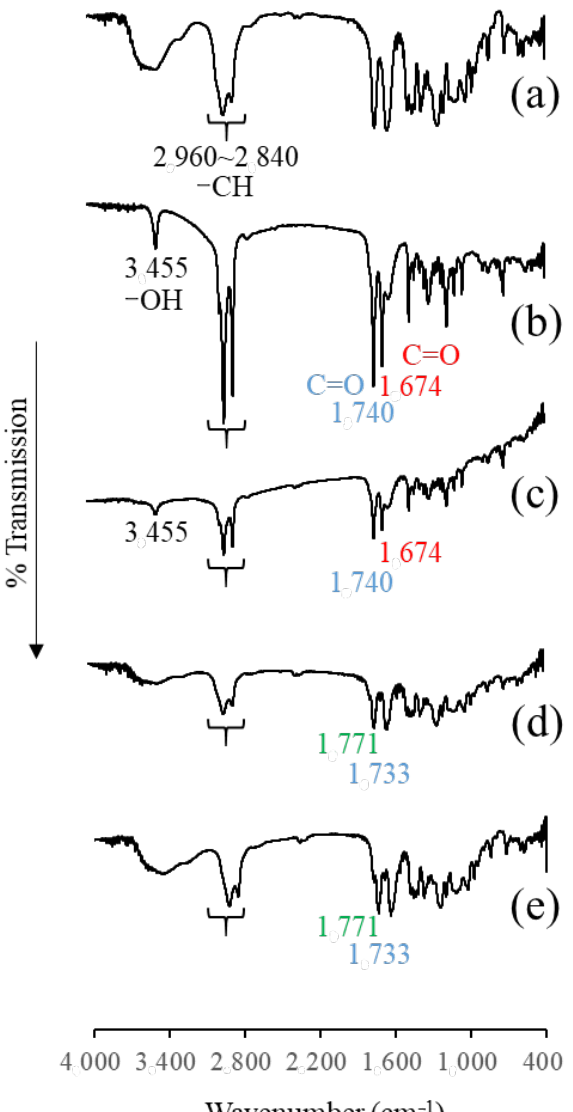
Figure 10. FT-IR absorption spectra of Sol/ASC-DP systems. ( a ) Sol, ( b ) ASC-DP, ( c ) PM (Sol/ASC- DP = 8/2), ( d ) EVP (Sol/ASC-DP = 9/1), ( e ) EVP (Sol/ASC-DP = 8/2). DP = 8/2), ( d ) EVP (Sol/ASC-DP = 9/1), ( e ) EVP (Sol/ASC-DP =